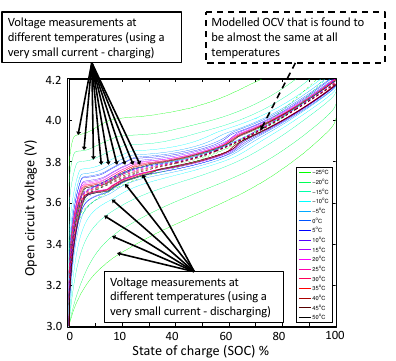
Figure 5. Normalized open-circuit voltage modelling. It is shown that the OCV-SOC parameters obtained through the proposed normalized OCV modelling approach in Reference [17,67] showed little variations with temperature.